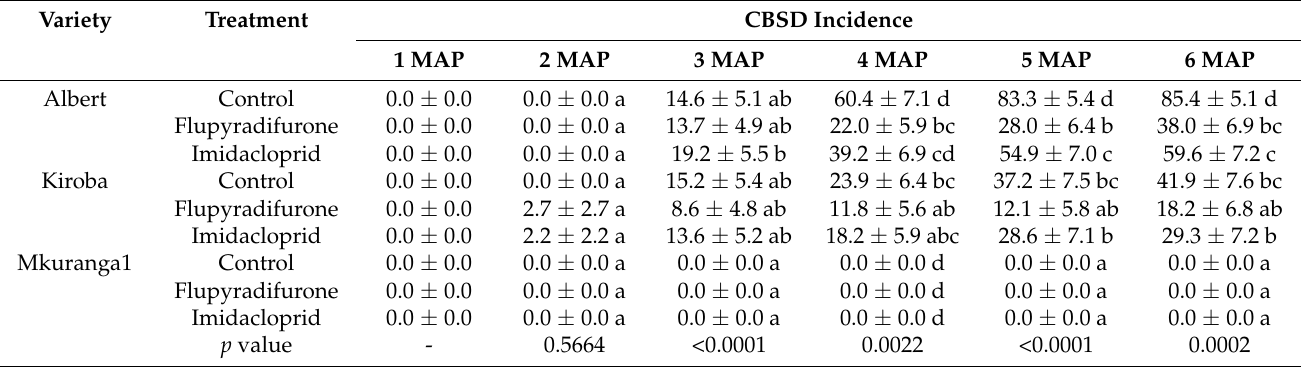
Table 4. Cassava brown streak disease (CBSD) percentage incidence for Vuli 2017 (Means ± SE) Z .